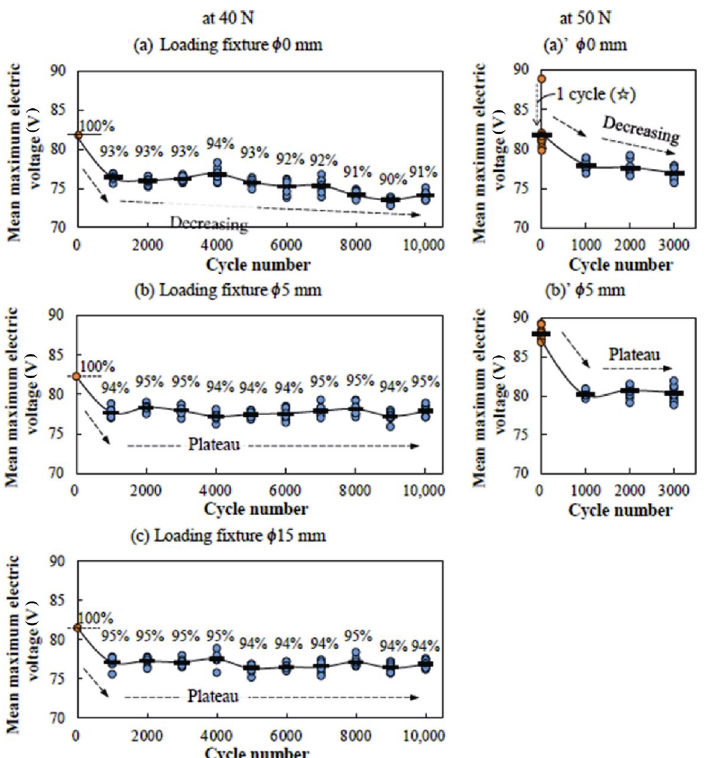
Fig. 13 Maximum voltage generated by PZT ceramic as a function of cycle number for (a) ϕ 0, (b) ϕ 5, and (c) ϕ 15 mm loading fixtures at loads of 40 N (left column) and 50 N (right column).